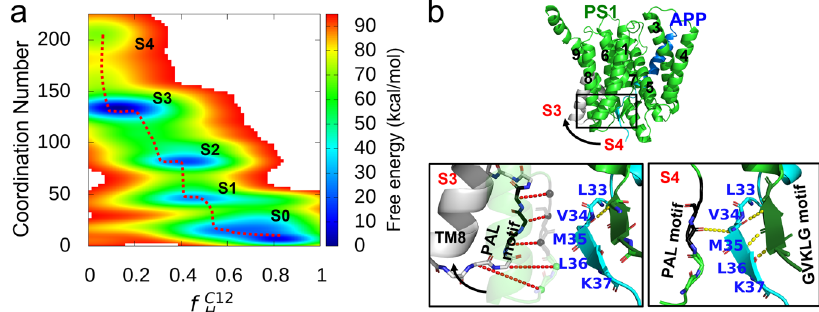
Fig. 3 Coupling between the unwinding of APP TMD and its binding with the PS1 intracellular interface. a Free energy pro fi les as a function of residual helicity for the C12 region of the APP TMD and the coordination number between PS1 and the APP TMD. All the intermediate states in the APP recognition process are labeled S0, S1, S2, S3, and S4. b Structural comparison of the GVKLG motif and PAL motif binding to the unwound part (cyan) of the APP TMD (blue) in states S3 and S4 (the PAL motif is in black, and the GVKLG motif is a forest-green β sheet). The red dashed lines represent the distance at which the C α atom at the PAL-containing loop moves with the conformational